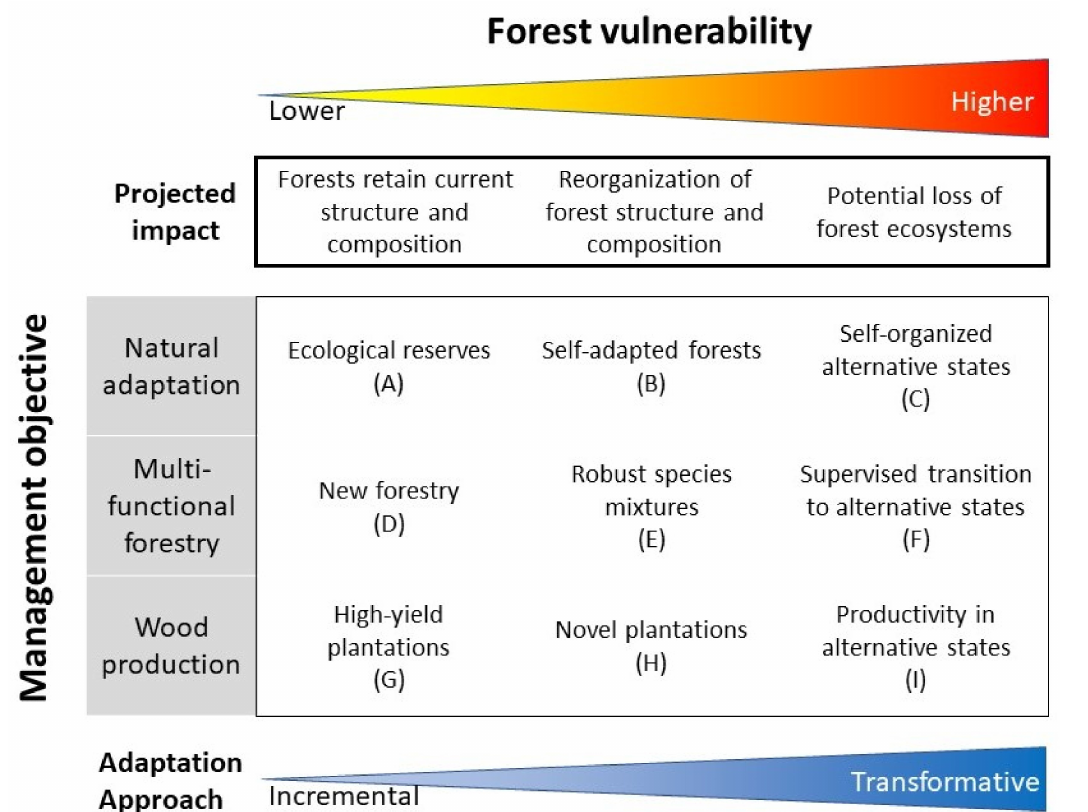
Figure 1. The functional zoning approach revisited in the context of climate change to provide a portfolio of adaptation options to climate change combining gradients of management objective and forest vulnerability. The three adaptation measures under lower vulnerability correspond to the traditional functional zoning management objectives [22]. Forests with higher vulnerability are more at risk of undergoing a transition toward alternative non-forest states and therefore transformative measures might be more suited. See the text for a description of management objectives and option names (highlighted in bold in the text), and Table 1 for a short description of each